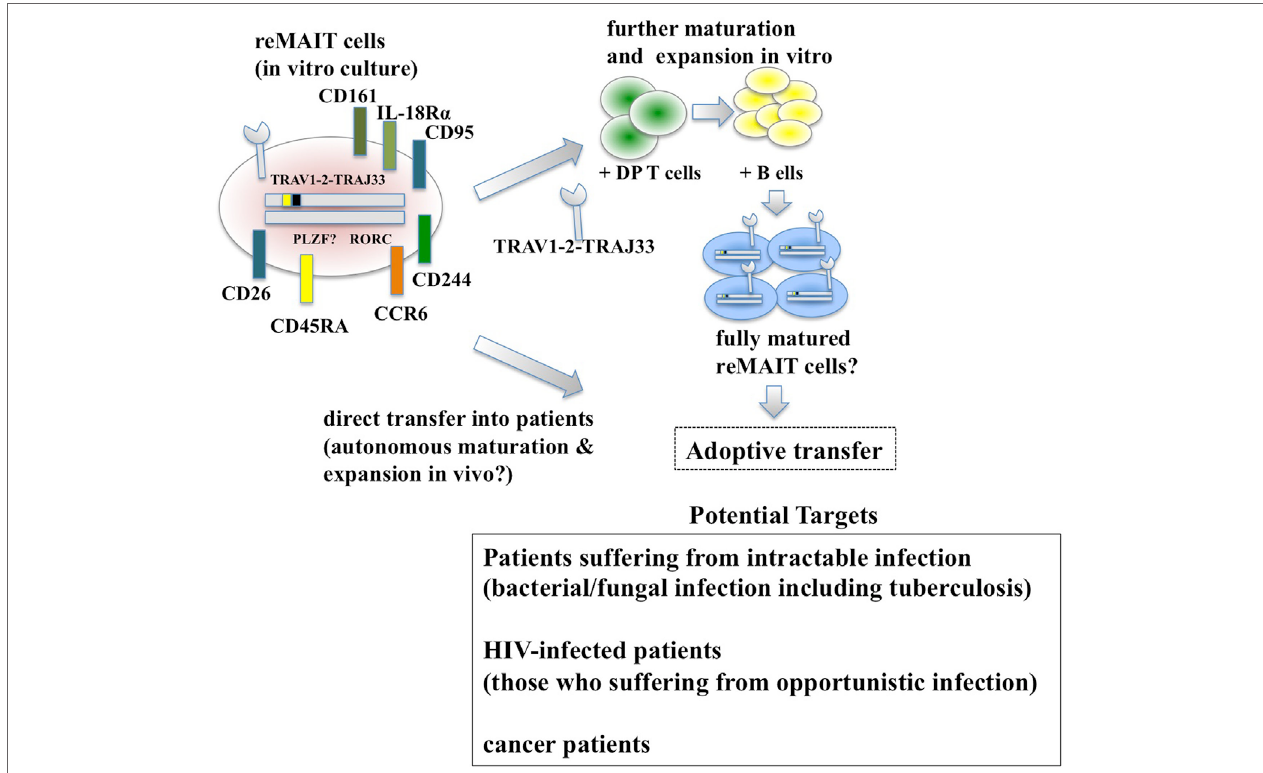
FiGURe 2 | Adoptive transfer of reMAIT cells for cell therapy. Fully matured reMAIT cells could be prepared before adoptive transfer (upper panel) or directly transferred into the patient (middle panel). In vitro -cultured reMAIT cells could further be maturated and expanded through interaction with double-positive (DP) T cells followed by incubation with B cells in vitro before adoptive transfer (upper panel). Alternatively, reMAIT cells could directly be transferred into patients for autonomous maturation and expansion in vivo (middle panel). Potential targets for cell therapy with reMAIT cells are indicated (lower